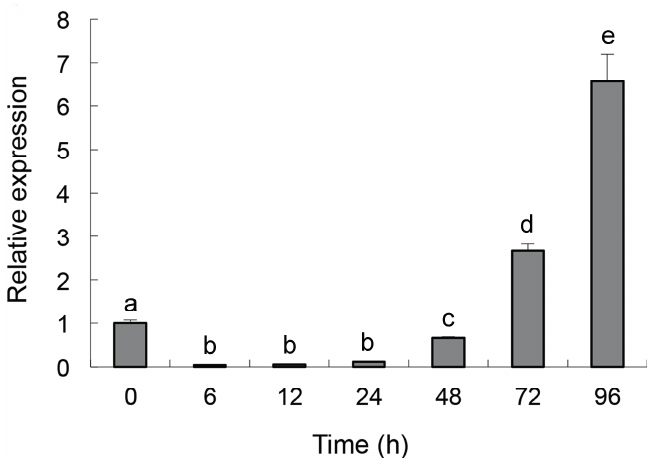
Figure 1. Expression of Per3 in C. rosea f. catenulata HL-1-1 under the induction of sclerotia of S. sclerotiorum , using quantitative real-time PCR. Error bars indicate the standard deviation of three replicates. Different letters represent significant differences ( p < 0.05) according to Duncan’s multiple range